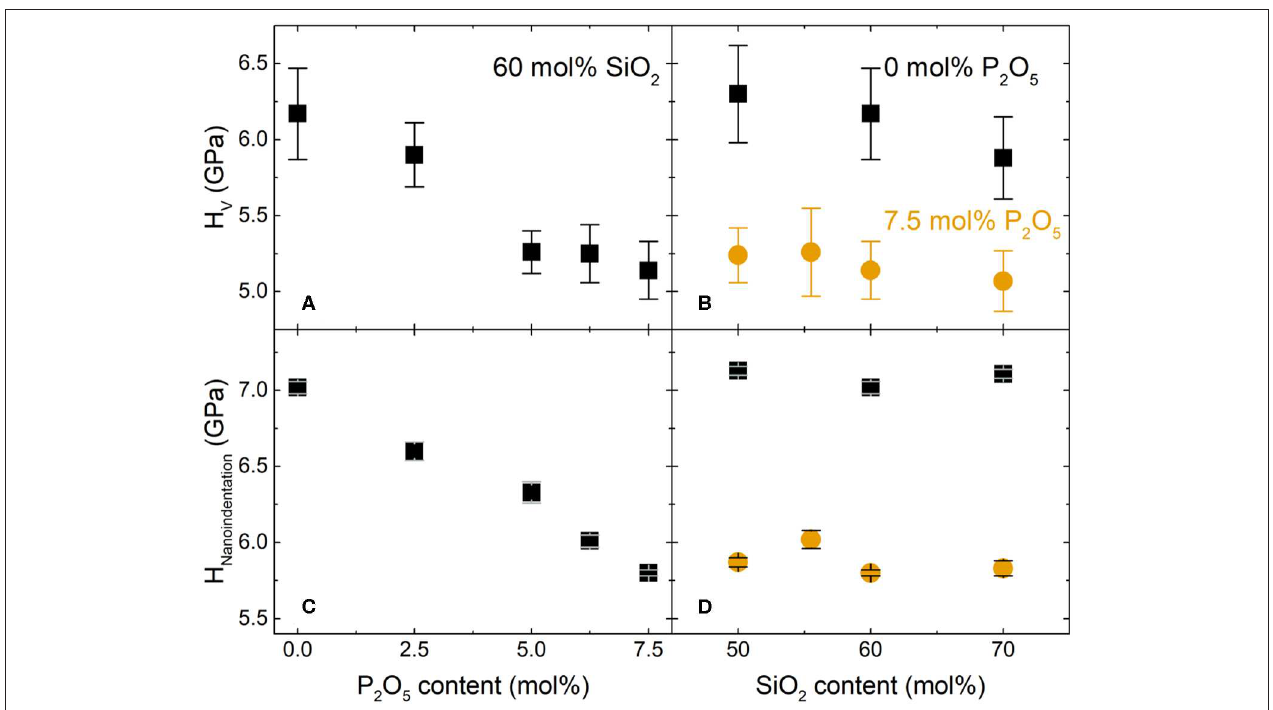
FIGURE 9 | Compositional dependence of (A,B) Vickers hardness, H v , and (C,D) hardness as determined by nanoindentation, H: (A,C) increasing P 2 O 5 content and constant 60 mol% SiO 2 , (B,D) increasing SiO 2 content and constant P 2 O 5 contents of 0 (black squares) or 7.5 mol% (orange